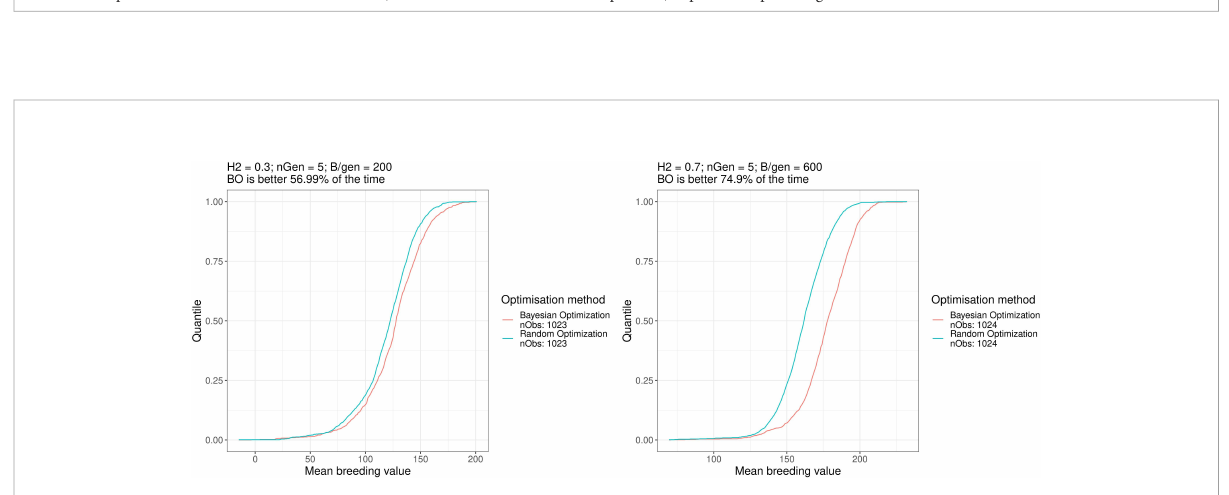
FIGURE 6 Empirical distribution functions of the breeding simulation results parametrised using the results of Bayesian optimisation and random optimisation for scenarios a. and f. Similar plots for all the scenarios can be found in the Supplementary